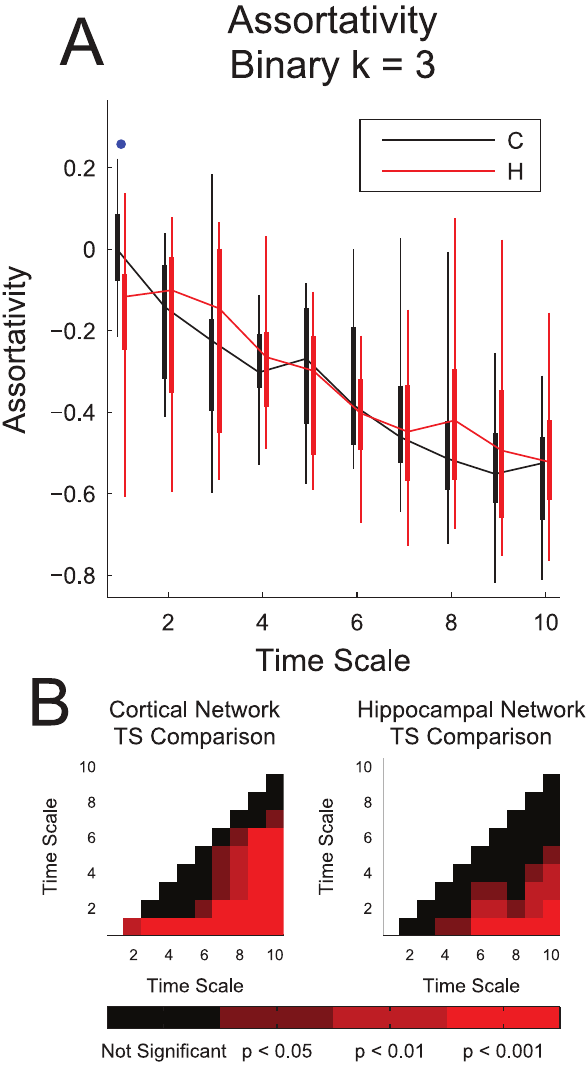
Fig. 8. Network assortativity decreased with time scale. ( A ) Network assortativity generally decreased (disassortativity generally increased) with time scale. Note the significantly higher assortativity for cortical networks at time scale 1 (interaction delays of 0.05 ms to 3 ms), and that the networks were generally disassortative. Box plots: minimum, 25 th percentile, median, 75 th percentile, maximum data set (recording). Differences between hippocampal and cortical networks were assessed with a multiple comparisons corrected Mann-Whitney Test (one dot: p , 0.05, two dots: p , 0.01, three dots: p , 0.001). ( B ) Multiple comparisons corrected Mann-Whitney Test p-values across different time scales for identical tissue types. Note that the decreasing behavior in (A) was generally significant.